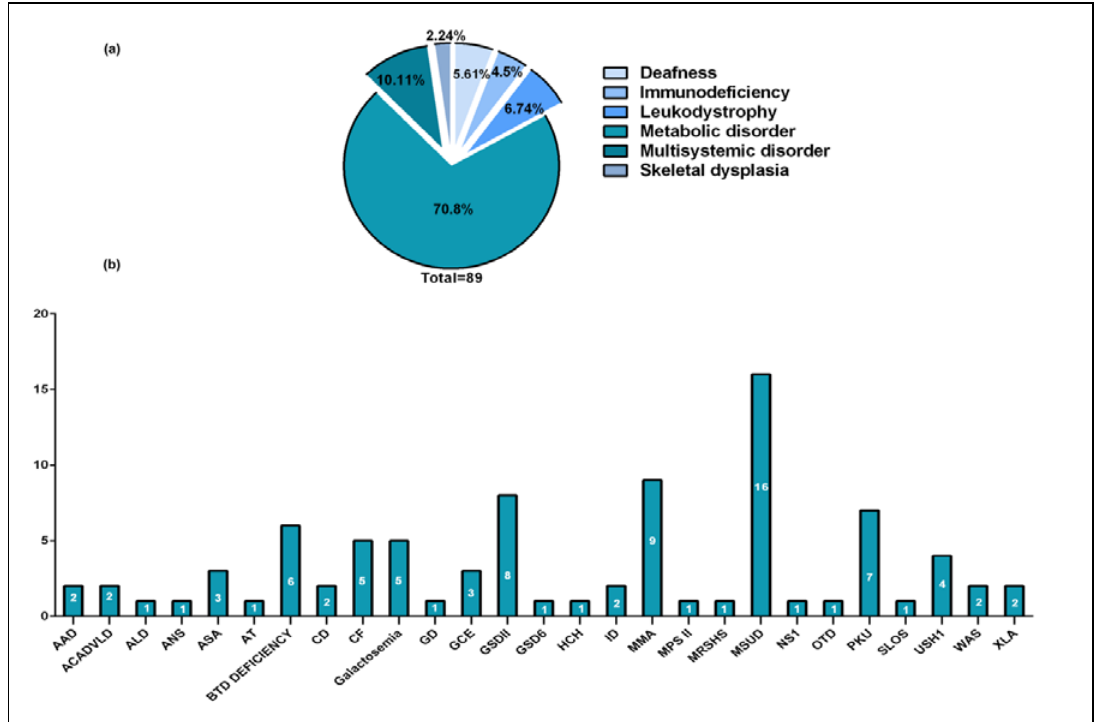
Figure 1. Disease categories and number of samples tested for each condition. ( a) Samples breakdown by disease category. ( b) Number of samples studied for each disease.